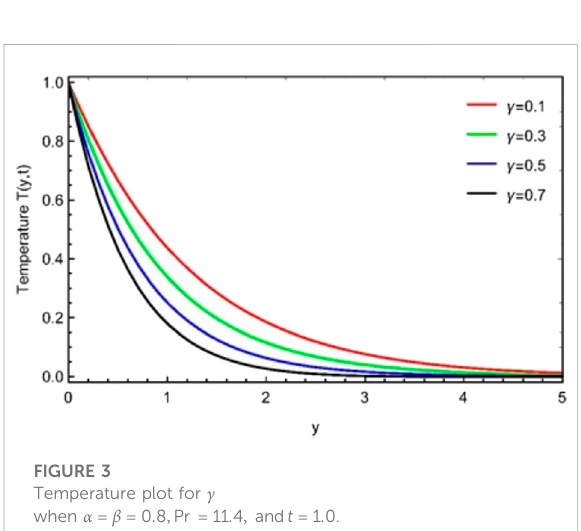
FIGURE 3 Temperature plot for γ when α (cid:3) β (cid:3) 0 . 8 , Pr (cid:3) 11 . 4 , and t (cid:3) 1 .